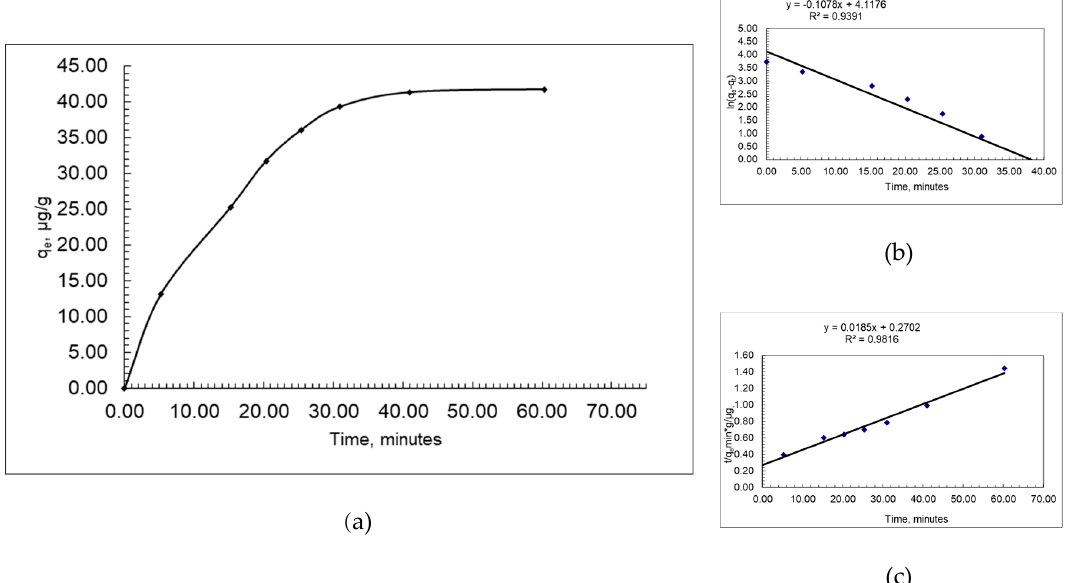
Figure 1. Adsorption ( a ), pseudo-first ( b ), and pseudo-second-order ( c ) kinetics of cypermethrin on Fucus